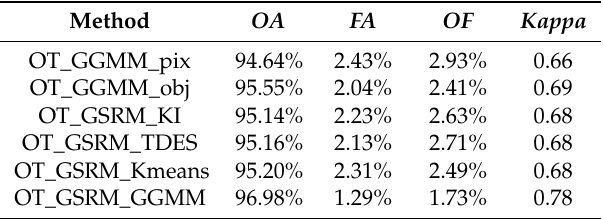
Table 4. Performance evaluation over LiangZi Lake between 2011 and 2015.